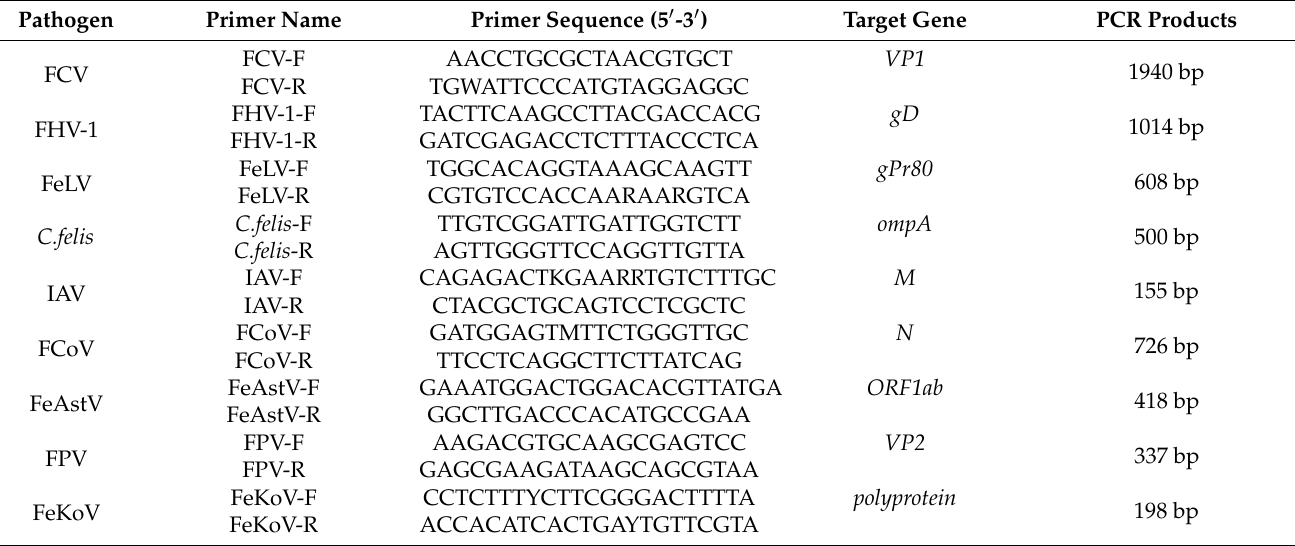
Table 1. Primers used for mPCRs.